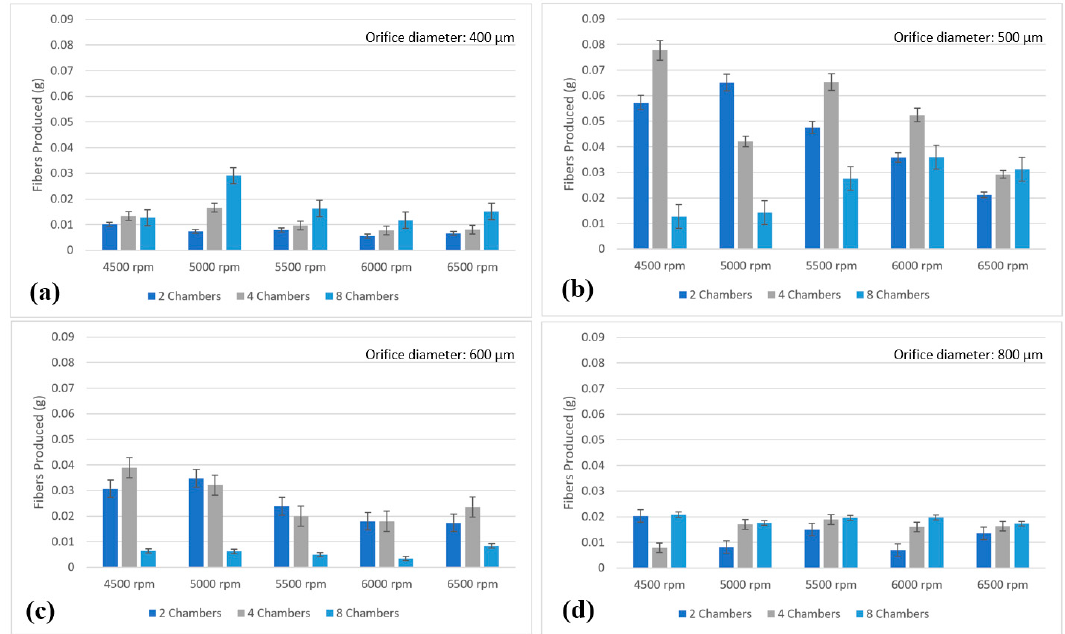
Figure 9. Mass basis quantitative analysis of fiber production using different rotational speeds (4500, 5000, 5500, 6000, and 6500 rpm) and number of chambers for different exit orifice diameters: ( a ) 400, ( b ) 500, ( c ) 600, and ( d ) 800 µm.